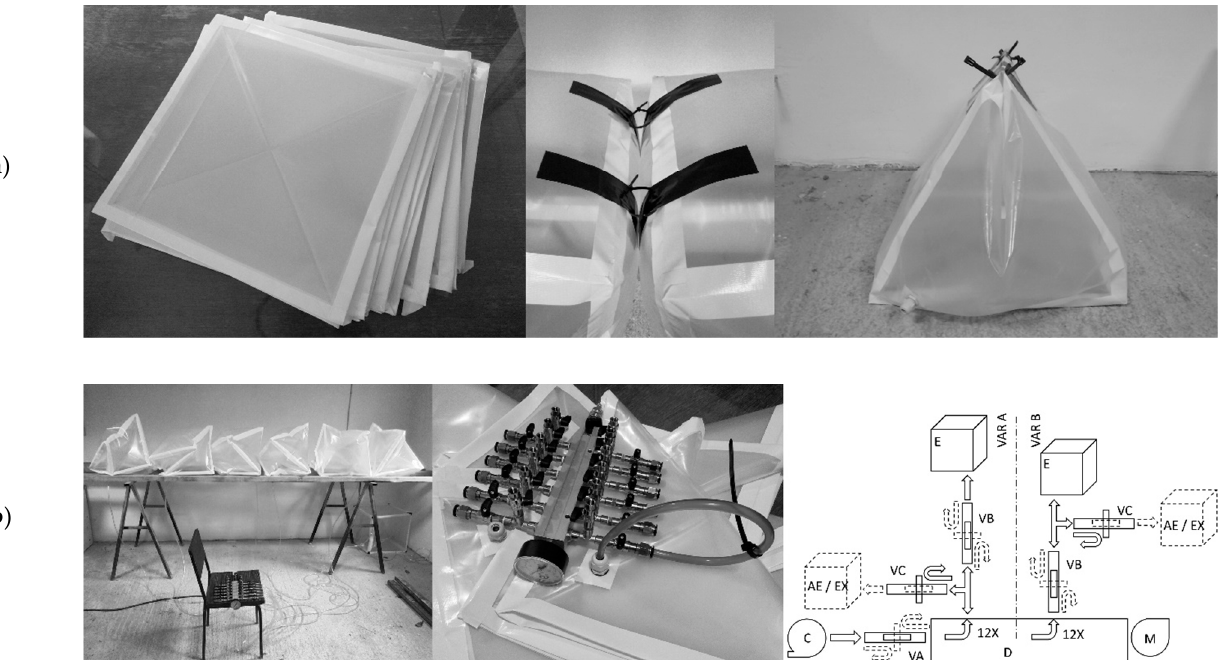
Figure 3. Parts of the physical model: ( a ) Unit elements, connection detail, folded wedge element; ( b ) The usual setup, air distributor, and schematics for the air distributor (C—compressor, VA: main valve, D—main distributor channel, M—manometer, VB—element valve, VC—valve for additional elements or exhaust, E—element, AE/EX—additional element/exhaust). Note: Tests were conducted in several different settings and on several occasions and they were documented using different cameras from which most illustrative photos or video snapshots were chosen. That is why some variations in viewing angle, resolution or color may be present in figures in this article.